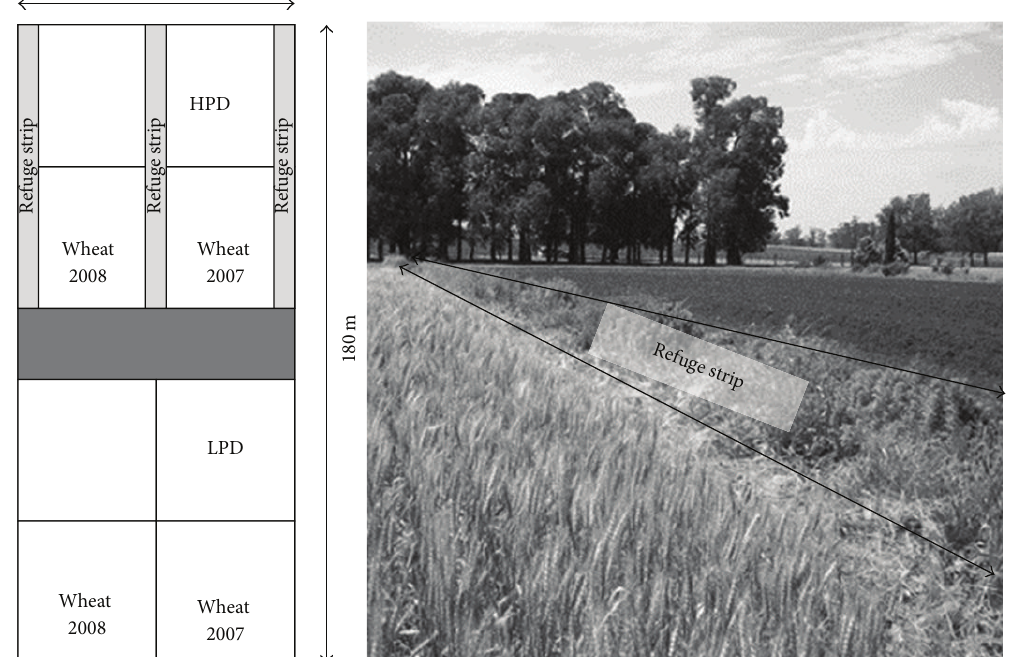
Figure 1: Representative plot to explain the layout of the two treatments of wheat crops with a high plant diversity (HPD) and low plant diversity (LPD) in 2007-2008. See text for a description of the experimental design. Table 1: Total and relative abundance of aphids on wheat crops with a high (HPD) and low plant diversity (LPD). Balcarce, 2007 and 2008. Schizaphis graminum Metopolophium dirhodum Sitobion avenae Systems Total ( n ) Total abundance Relative Total abundance Relative Total abundance Relative (no.) abundance (%) (no.) abundance (%) (no.) abundance (%) HPD 43 2007 2008 LPD 102 17,09 597